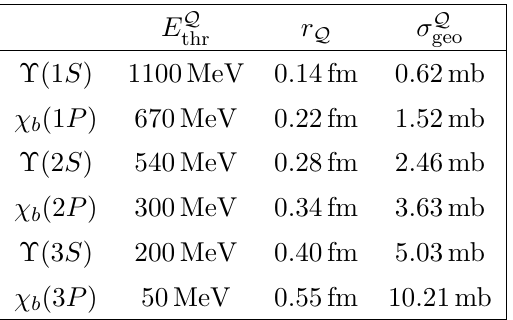
Table 1 . Di(cid:11)erent (cid:12)xed parameters used in our parametrisation of the (cid:7)-comover cross sections. The values of E Q correspond to m co = thr